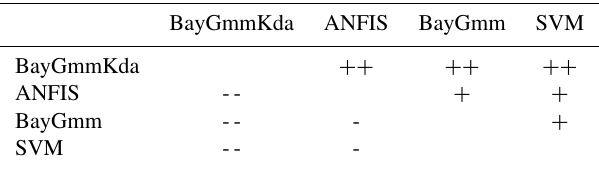
Table 4. Model comparison based on the Wilcoxon signed-rank